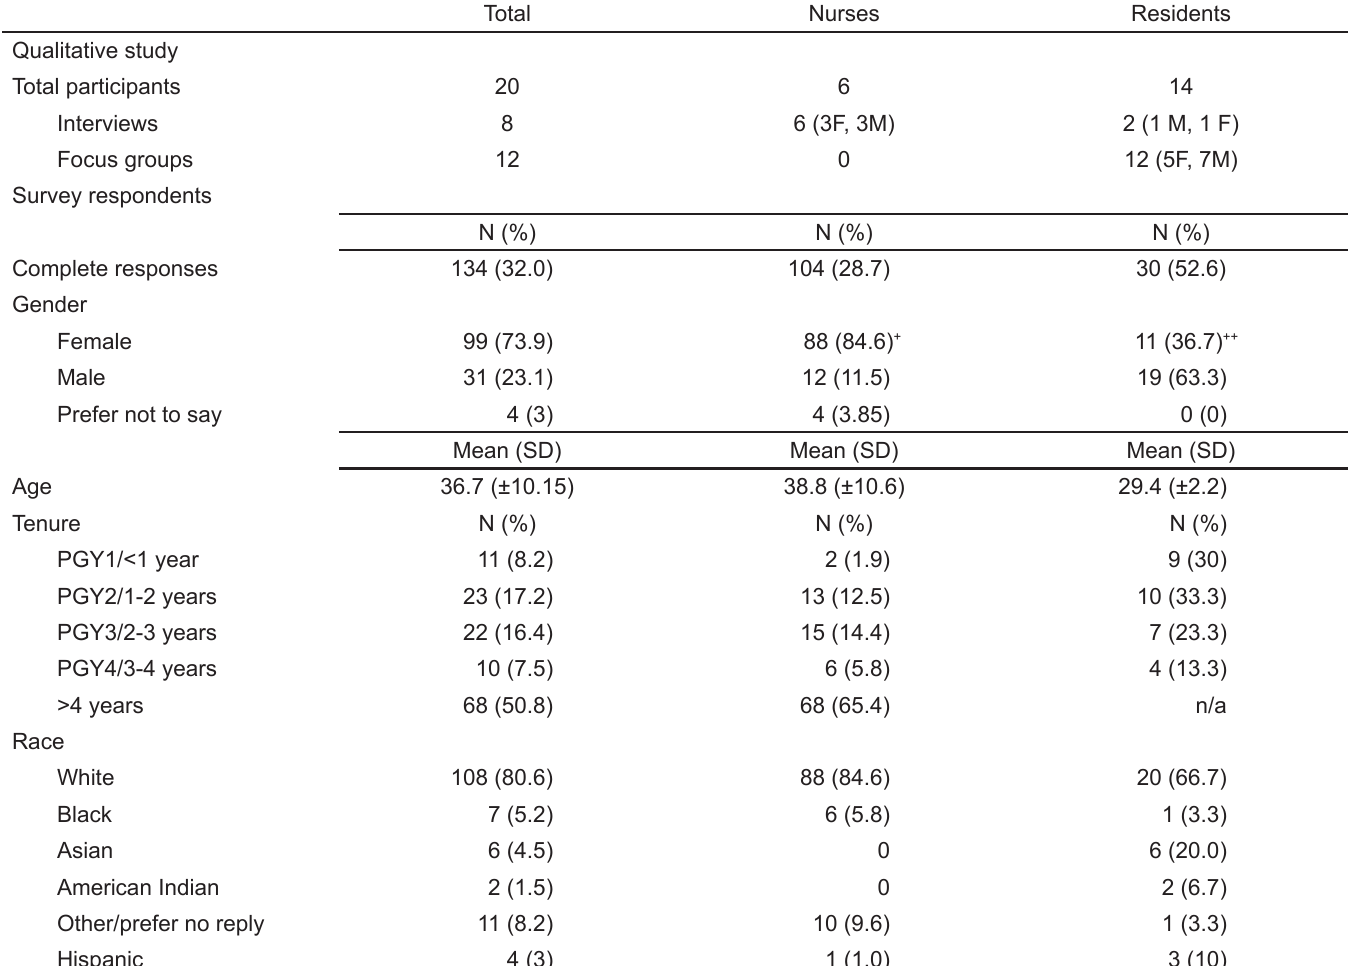
Table 1. Demographics of participants by